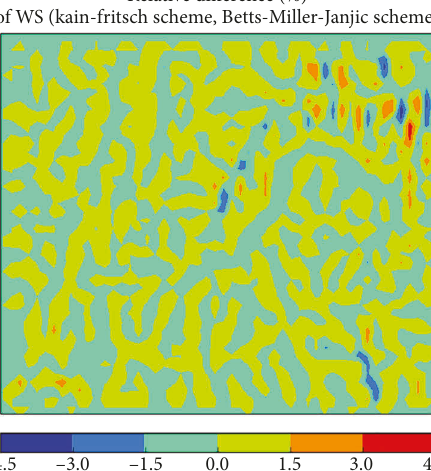
Figure 2: Relative difference (%) of wind speed between two simulations: one using Kain–Fischer scheme and the other using Betts–Miller–Janjic scheme.